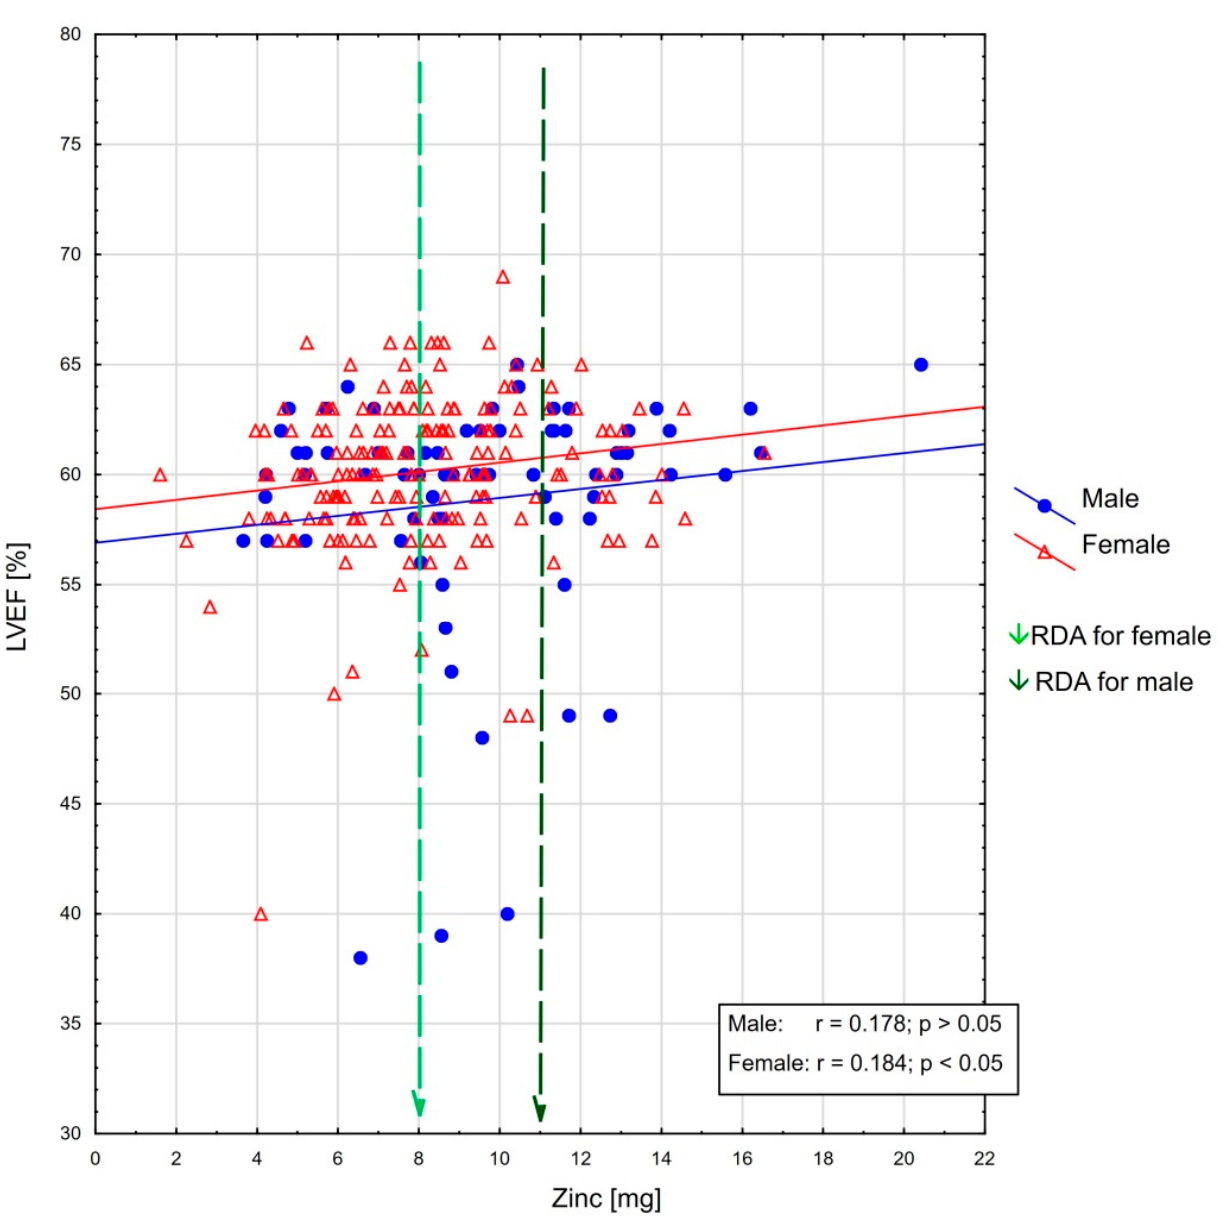
Figure 1. The association between LVEF [%] and zinc intake as well as RDA recommendations in the female and male groups (linear trend line added for easier interpretation).